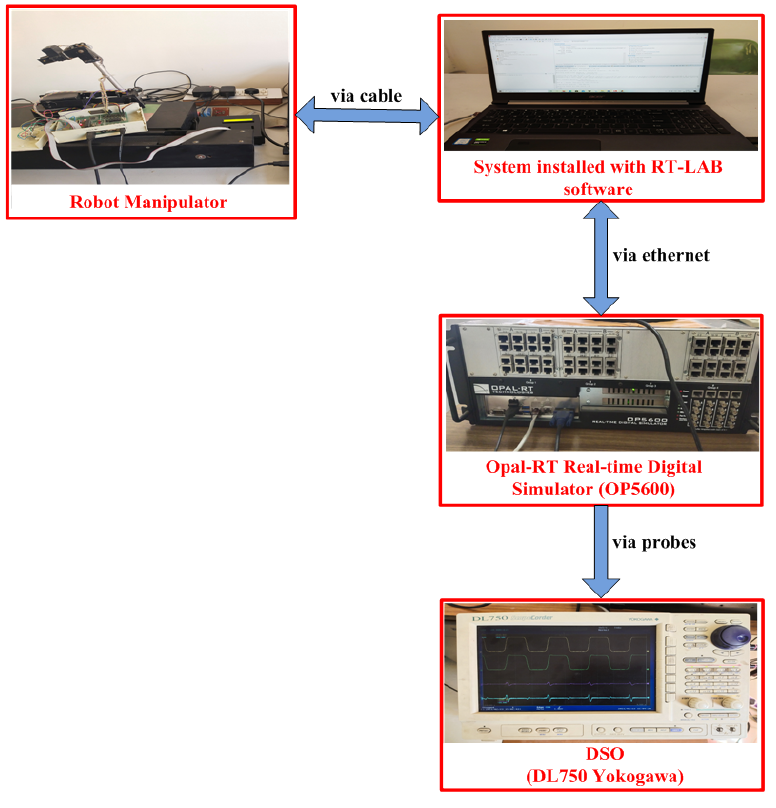
Figure 7. Experimental setup.